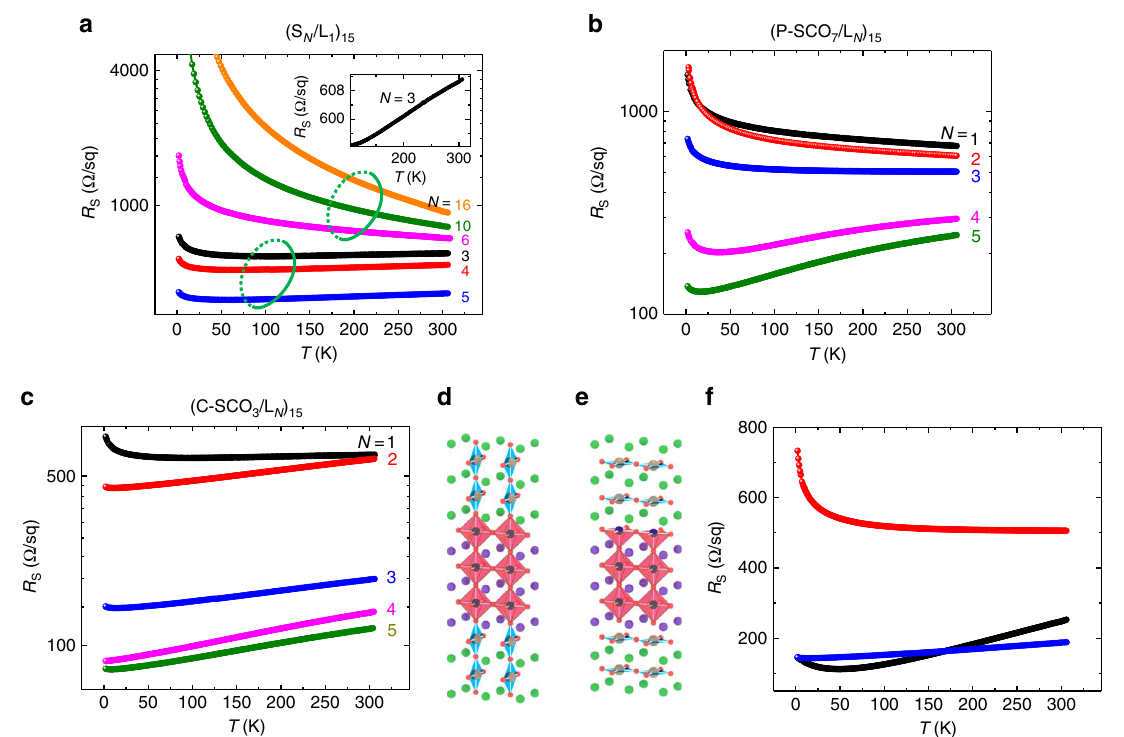
Fig. 5 Metal-to-insulator transition by dimensionality control in superlattices. Temperature dependent sheet resistance of a (S N /L 1 ) 15 , b (P – SCO 7 /L N ) 15 , and c (C – SCO 3 /L N ) 15 for various layer thickness ( N ) of a SCO or b , c LNO. The green ellipses in a group separately the metallic and insulating superlattices. S, L, P – SCO, and C – SCO represent SrCuO 2 (SCO), LaNiO 3 (LNO), planar-type SCO, and chain-type SCO, respectively. Structural models for d (C – SCO 7 / L 3 ) 15 and e (P – SCO 3 /L 3 ) 15 superlattices. f Temperature dependent sheet resistance of (C – SCO 7 /L 3 ) 15 (blue curves), (P – SCO 3 /L 3 ) 15 (red curves),